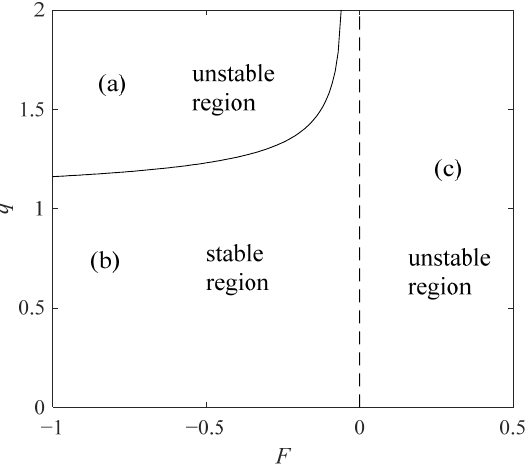
Figure 2. The bifurcation diagram about Equation (3) for equilibrium ( 0,0 ) . (cid:16) ±√ (cid:17) F , 0 At equilibrium , the system is stable for 0 < F ≤ δ 2 /8. When F > δ 2 /8, the boundary condition of instability is 2 2 = 2 − ) | , ( i = 1, 2 ) , i.e., q | arg ( λ q 0 = arctan 0 i π π (cid:16) ±√ (cid:17) F , 0 The critical line corresponding to point is given in Figure 3, where the equilibrium point is stable below the critical line and unstable above it.